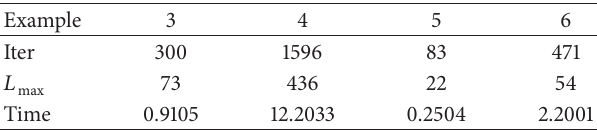
Table 1: 𝛼 = 0.5 ; the reduction cut and new upper bound updating are not adopted.